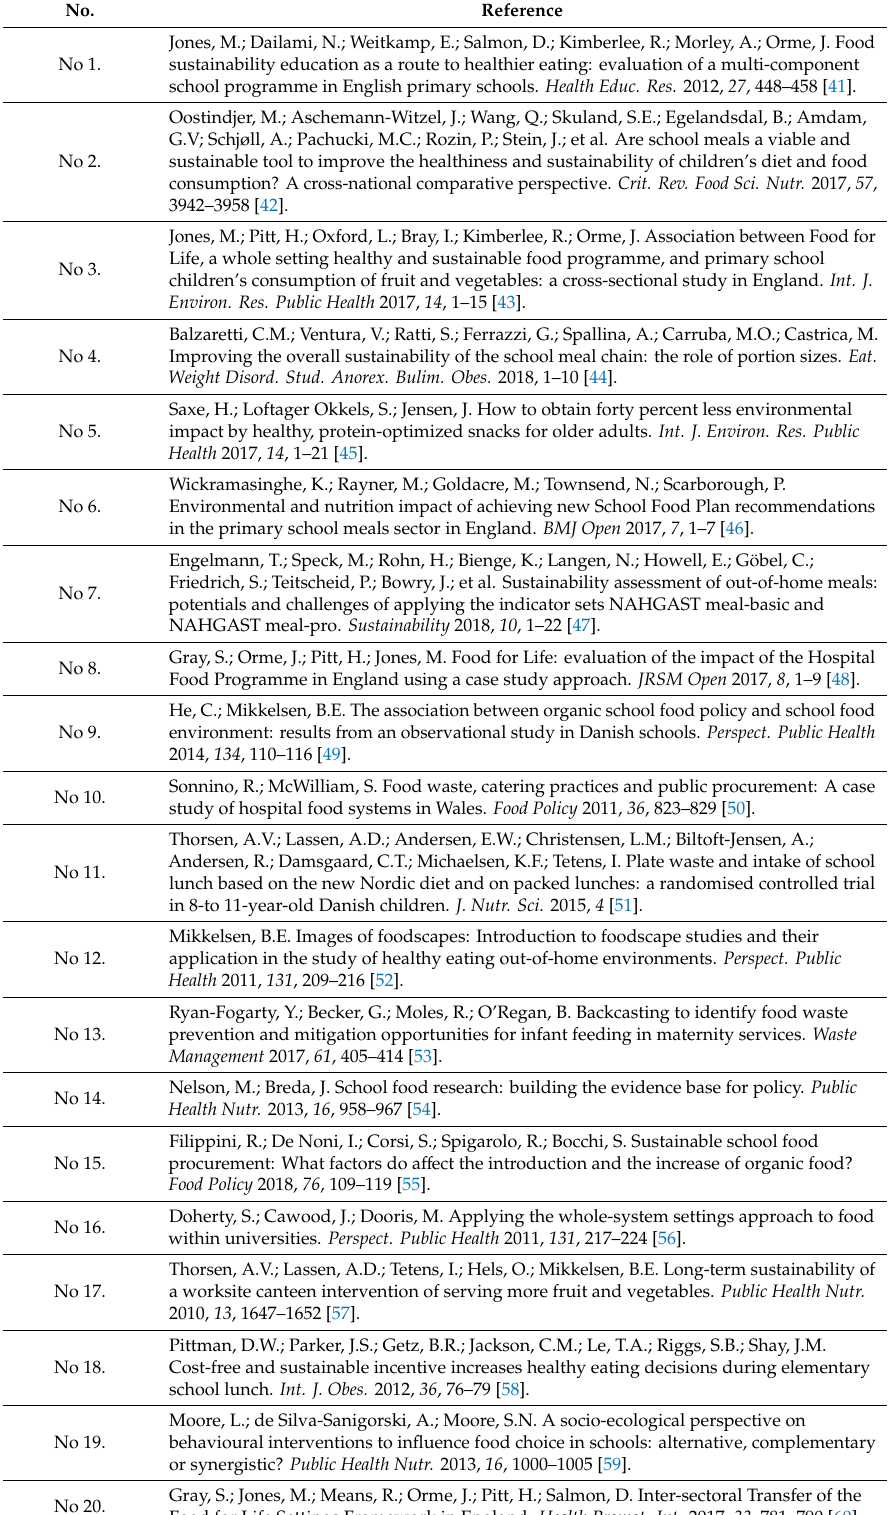
Table 3. The 20 articles on health and sustainability in public meals fulfilling the five criteria for inclusion in this